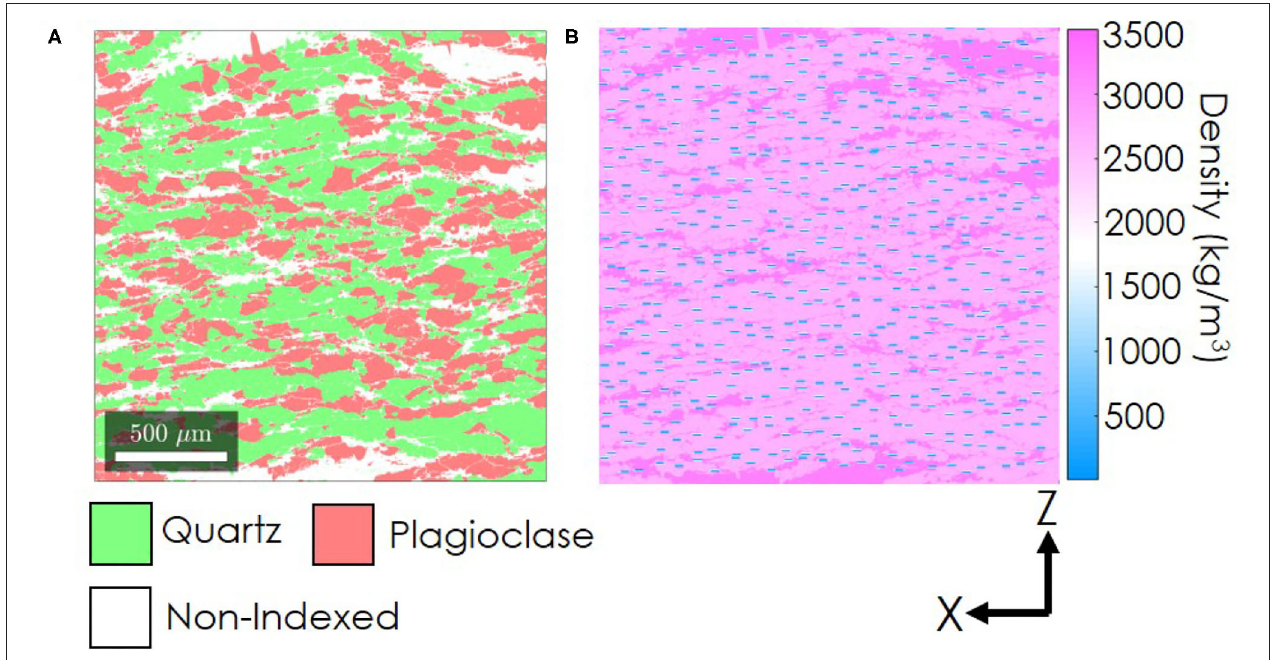
FIGURE 7 | (A) Schist EBSD data cut perpendicular to foliation and (B) the EWAVE model of the schist data with 5% fractures included. The color represents the phase density. The air-filled fractures are shown in